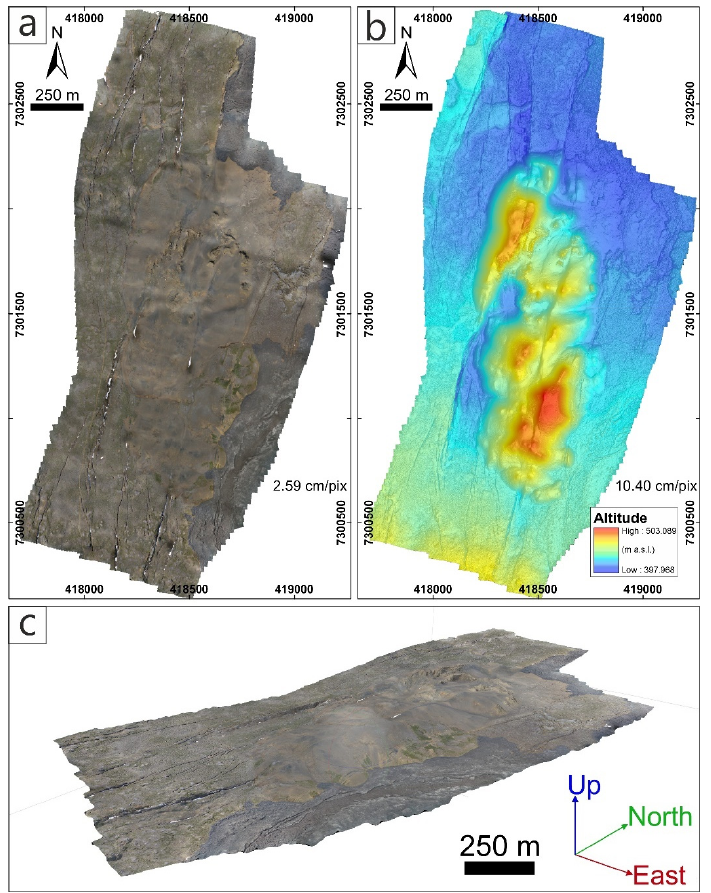
Figure 5. SfM-derived orthomosaic ( a ) and DSM ( b ) of the study area, with corresponding resolution indicated in the lower right corner. Altitudes are shown as a colour range (legend in figure); reference system: UTM28-WGS84. ( c ) The final 3-D tiled model.